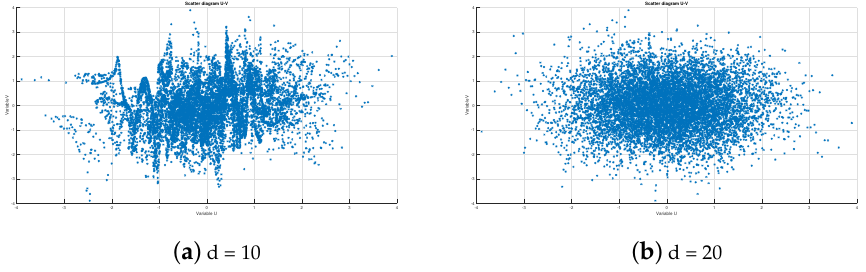
Figure 10. Scatter diagrams U–V for the Clifford map for different d distances.